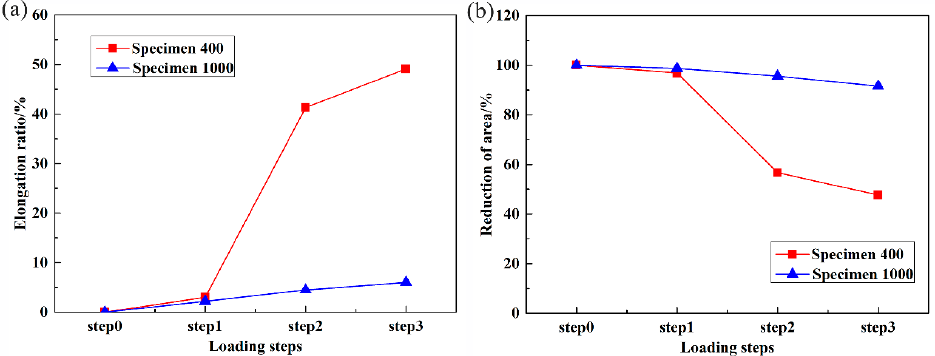
Figure 7. ( a ) Elongation ratios at di ff erent loading steps; ( b ) reductions of the area at di ff erent load- ing